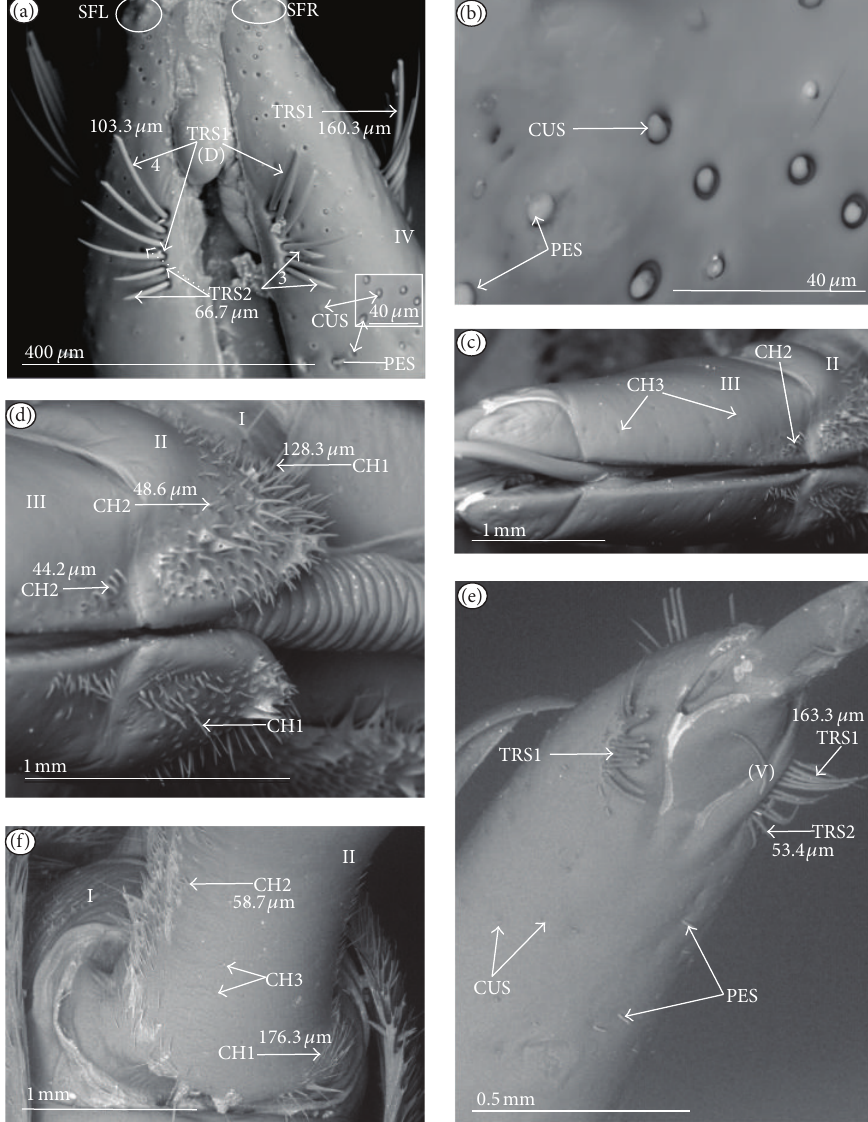
Figure 12: Types, sizes, and distribution of the sensilla of the Belostomatinae ( Hydrocyrius colombiae ). (a) TRS1 (four), TRS2 (three) form one row and are placed dorsally (D) near the apex of the labium; sensory fields (SFR, SFL); CUS and PES, placed dorsally, are numerous and unevenly distributed on segment IV. (b) CUS and PES (magnified). (c) CH3 are sparsely and unevenly distributed, dorsal view of segment III, several CH2 grouped near the labial groove. (d) CH2 are numerous, placed on the dorsal side, on segment II. (e) TRS1, TRS2 are distributed ventrally (V); CUS, PES, and CH3 are sparsely and unevenly distributed ventrally on the IV segment. (f) CH1 are visible at the base of segment II on the ventral side, CH2 are densely arranged along the surface of the second segment, and CH3 are slightly visible and unevenly distributed over segment